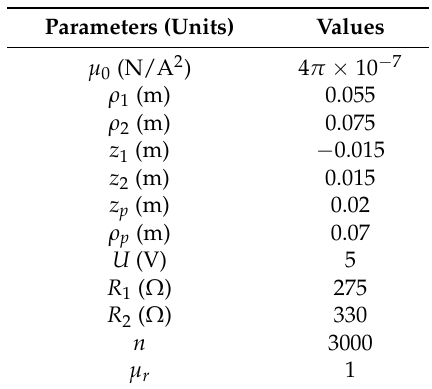
Table 1. Parameter Table 1. Parameter values.